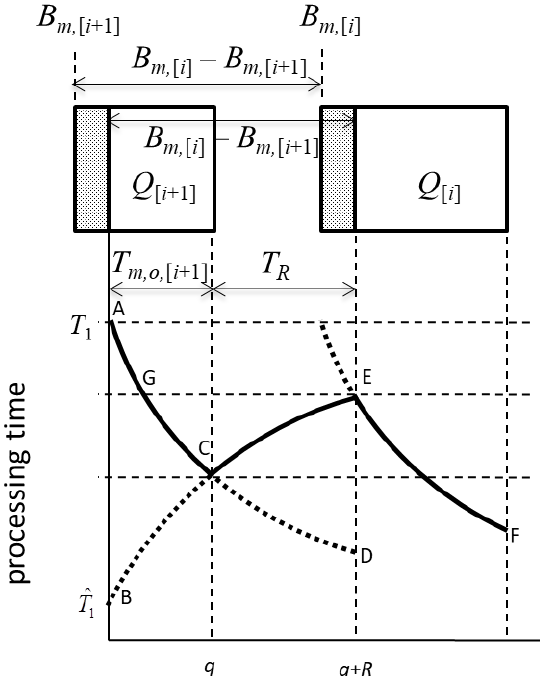
Figure 1. Learning and forgetting effects during two consecutive